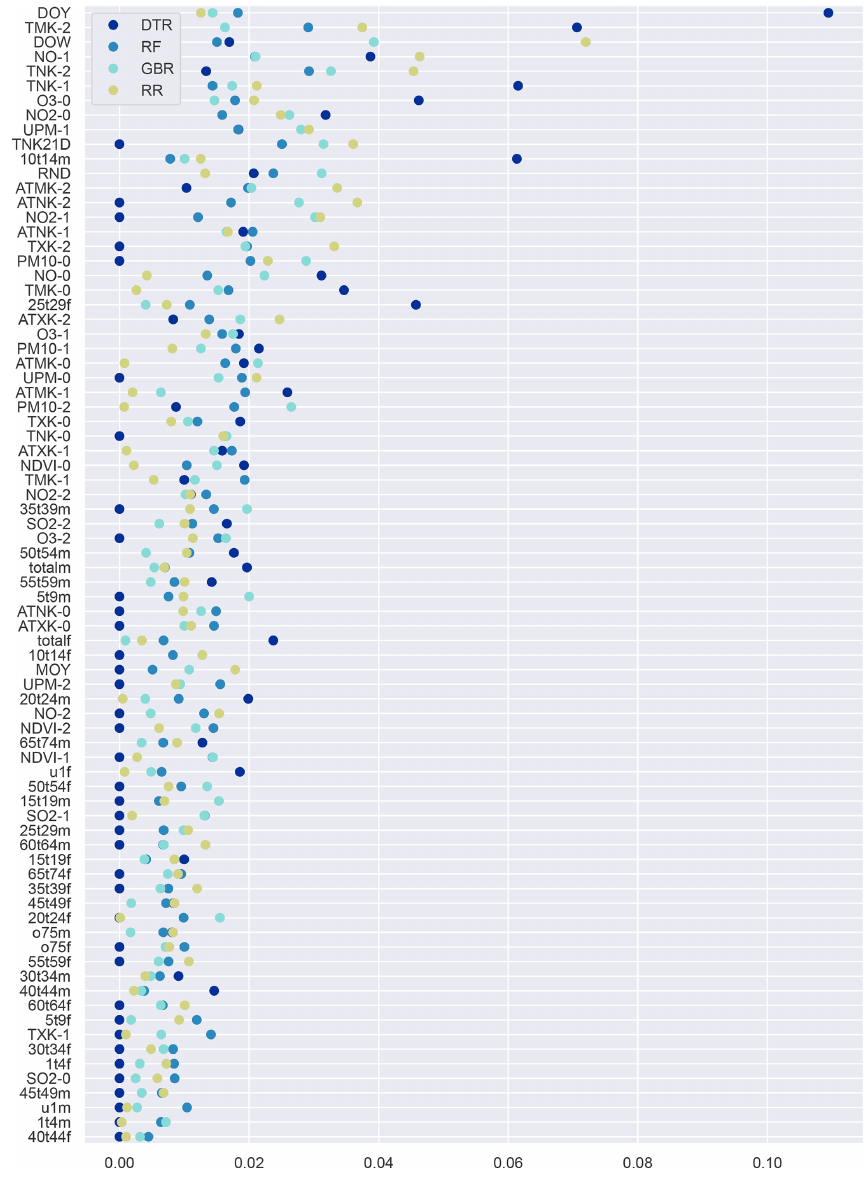
Figure A7. Feature importance for predicting MI in the general population when the full set of demographic features is used. Where applicable the lag in days (0, 1 or 2) is indicated. Larger values indicate higher importance, and per model the sum over all features equals